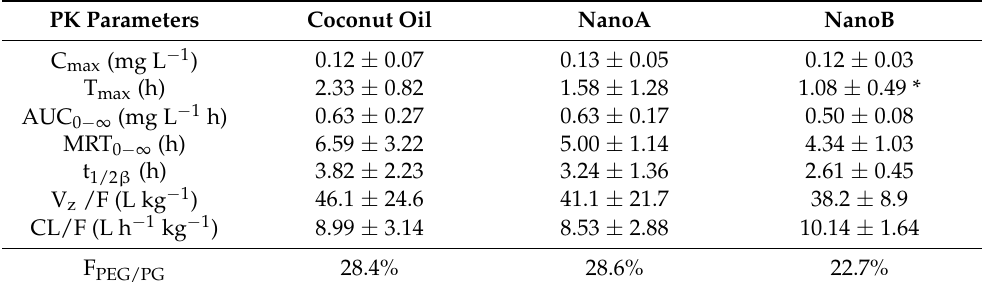
Table 6. Pharmacokinetic parameters of the coconut oil solution ( n = 6) and NanoA and NanoB suspensions ( n = 6) following oral administration at a dose of 5 mg/kg in male Sprague–Dawley